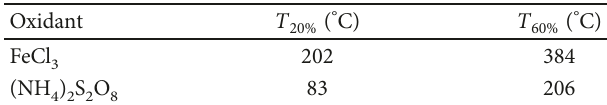
Table 4: TGA results for PPy samples with FeCl as oxidants. Oxidant